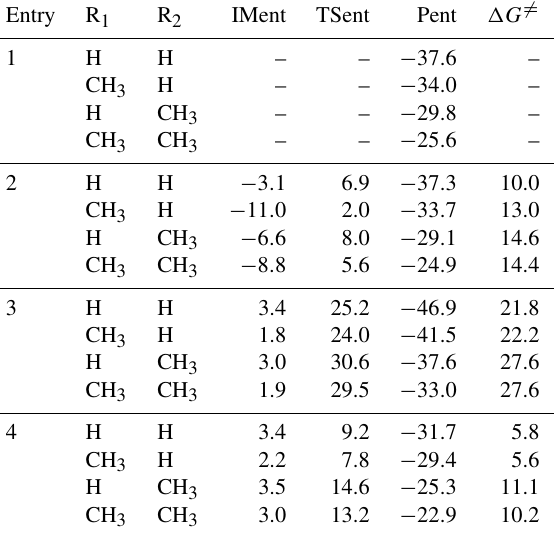
Table 1. Relative free energies of stationary points and free en- ergy barriers ( (cid:49)G (cid:54)= ) at 298K (in kcalmol − 1 ) for the various SCI (R 1 R 2 COO, R 1 , and R 2 = H, CH 3 ) reactions with HCOOH calcu- lated at the M06-2X/ma-TZVP//M06-2X/6-311 + G(2df,2p) level of